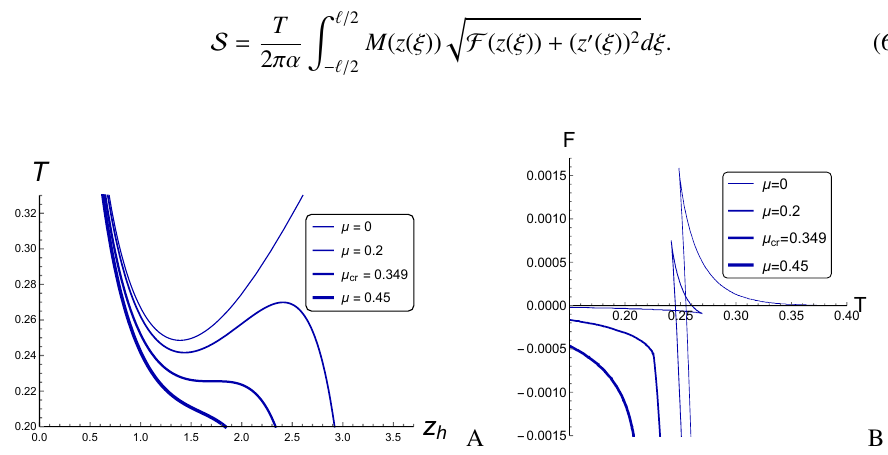
1, ν = 4 . 5 and di ff erent µ B) The free −